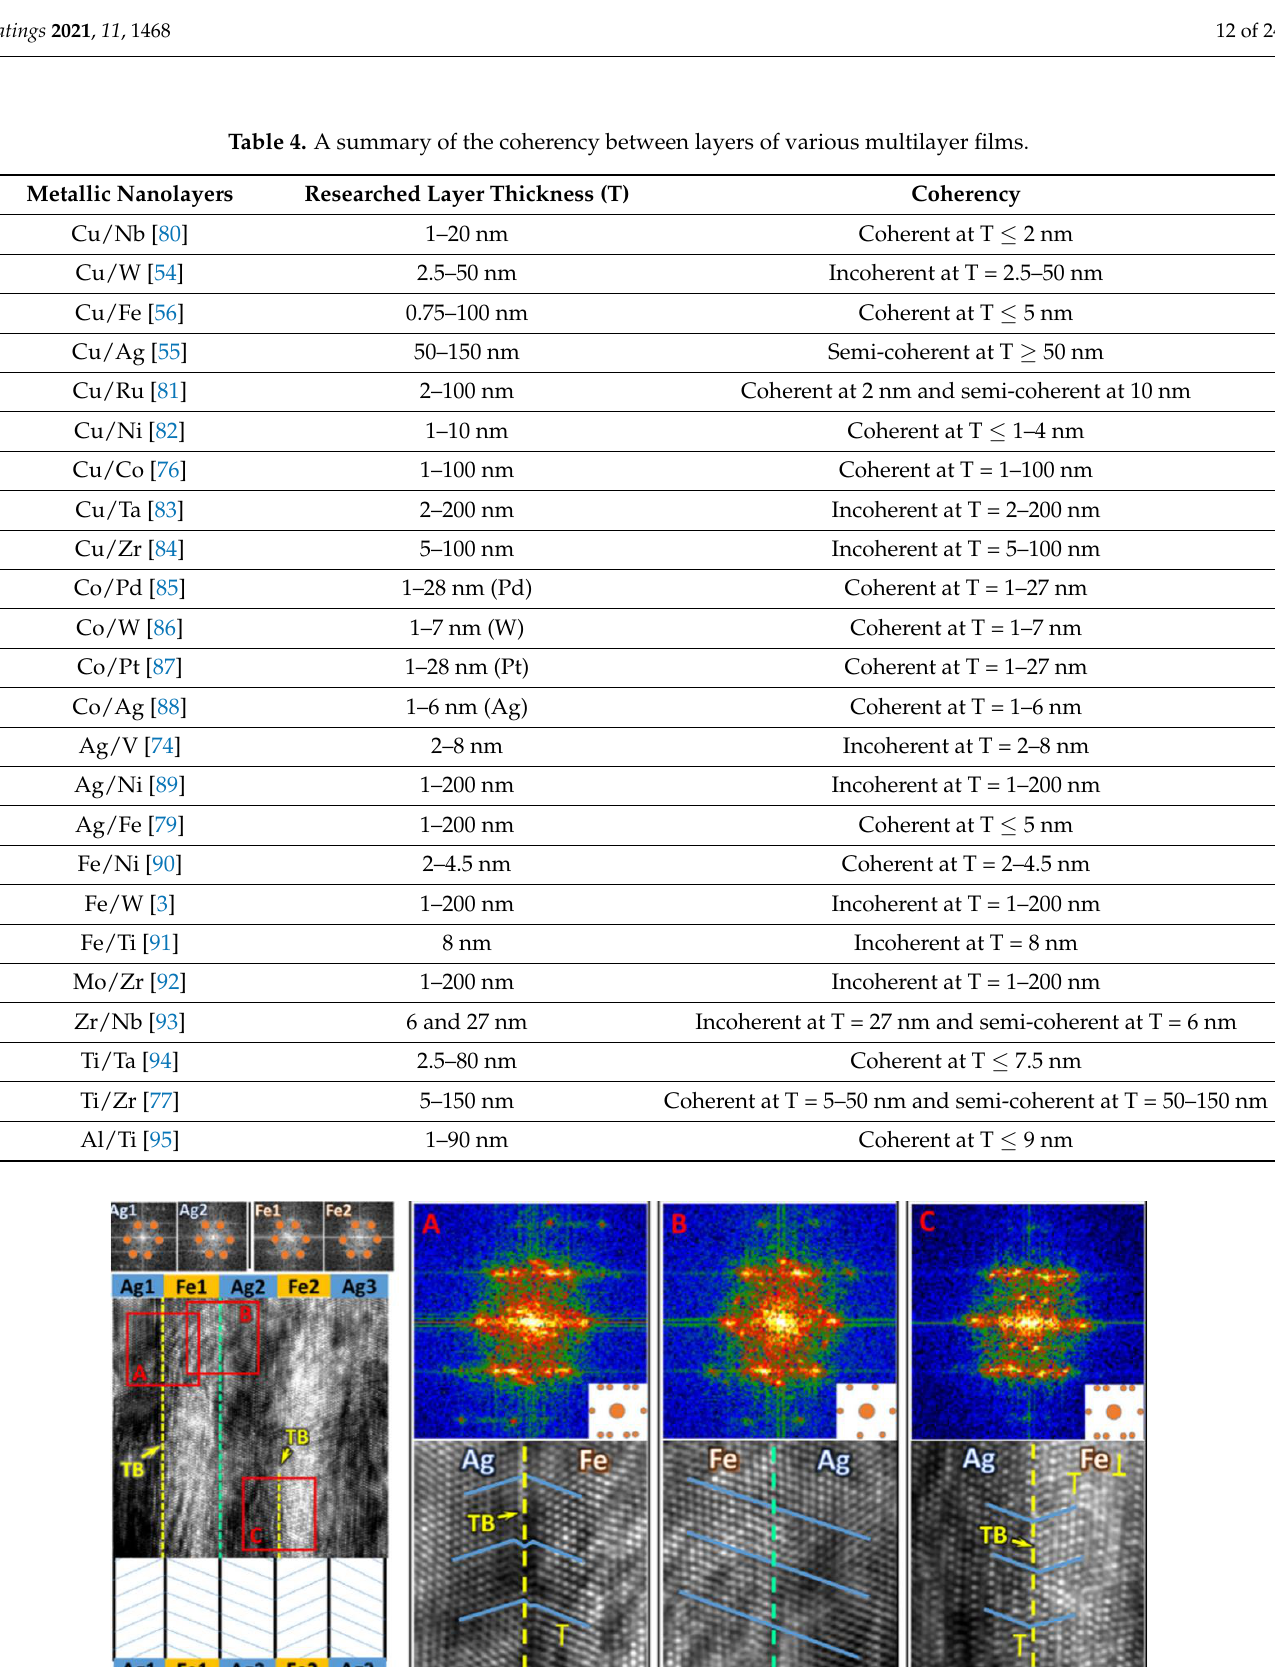
Figure 9. The HRTEM micrograph of the multilayer combined with the FFT of each individual layer and schematics showing the formation of twin boundaries and coherent interface in the Ag/Fe 5 nm multilayer film [79]. A, B, and C displayed three different locations. Reprinted with permission from [79] Elsevier 2016. Table 4. A summary of the coherency between layers of various multilayer films.